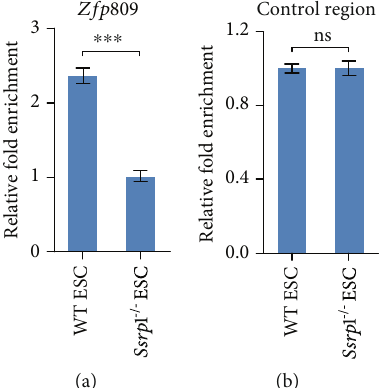
Figure 4: H3K36me2 enrichment on MERVL-fused genes. (a, b) ChIP-qPCR analysis of H3K36me2 enrichment on MERVL-fused gene Zfp809 (a) and control region (b) in WT ESC and Ssrp1 -/- ESC with normalization to Gapdh and input; data shown as mean ± s : e : m